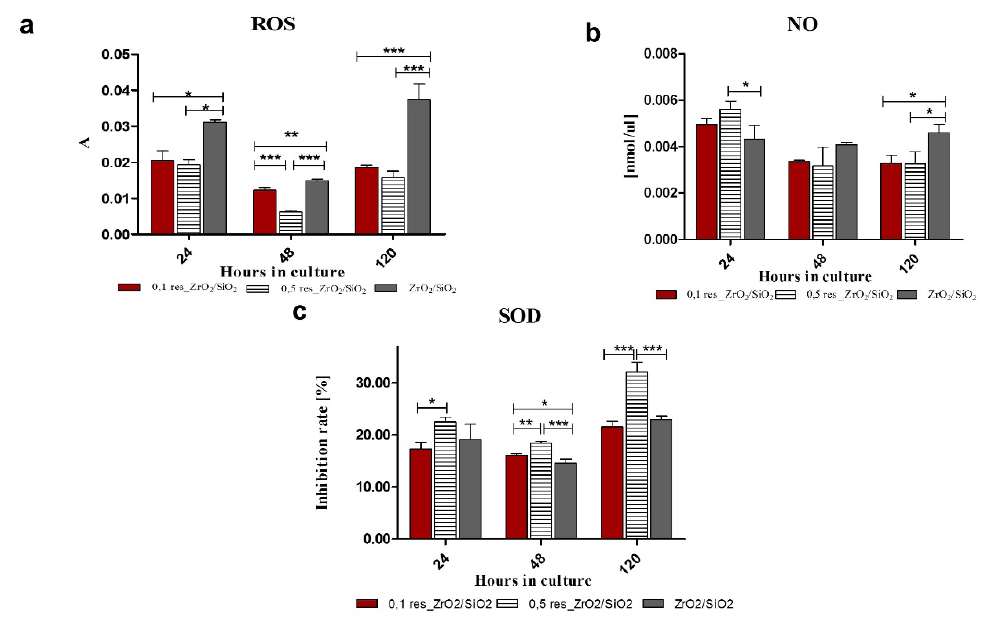
Figure 7: Analysis of the oxidative stress factors in ASCs: the levels of reactive oxygen species (a), amount of nitirc oxide (b) and activity of superoxide dismutase (c). Results expressed as mean ± SD *pvalue<0.05,. **pvalue<0.01, ***pvalue<0.001